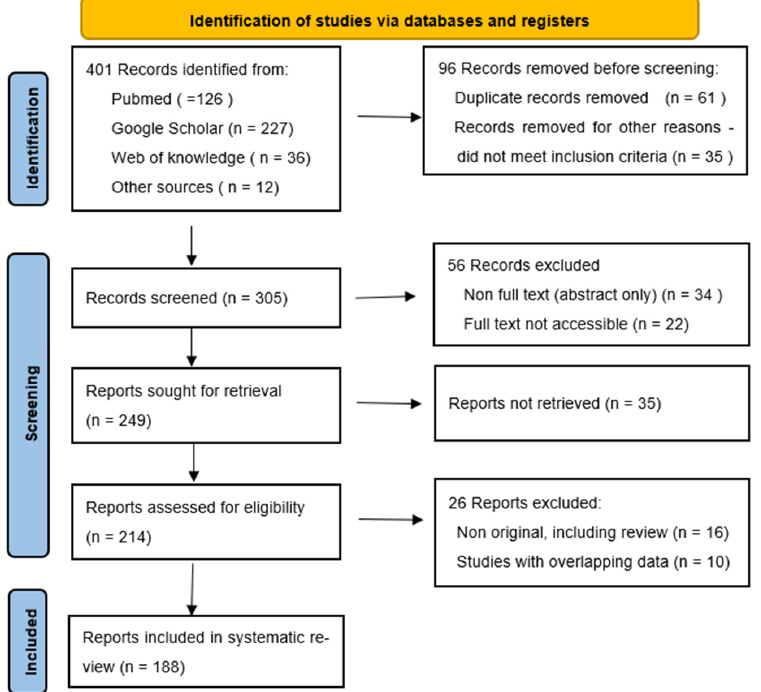
Figure 1. PRISMA 2020 flow diagram showing the search strategy, the number of records identified, and the number of included/excluded records.